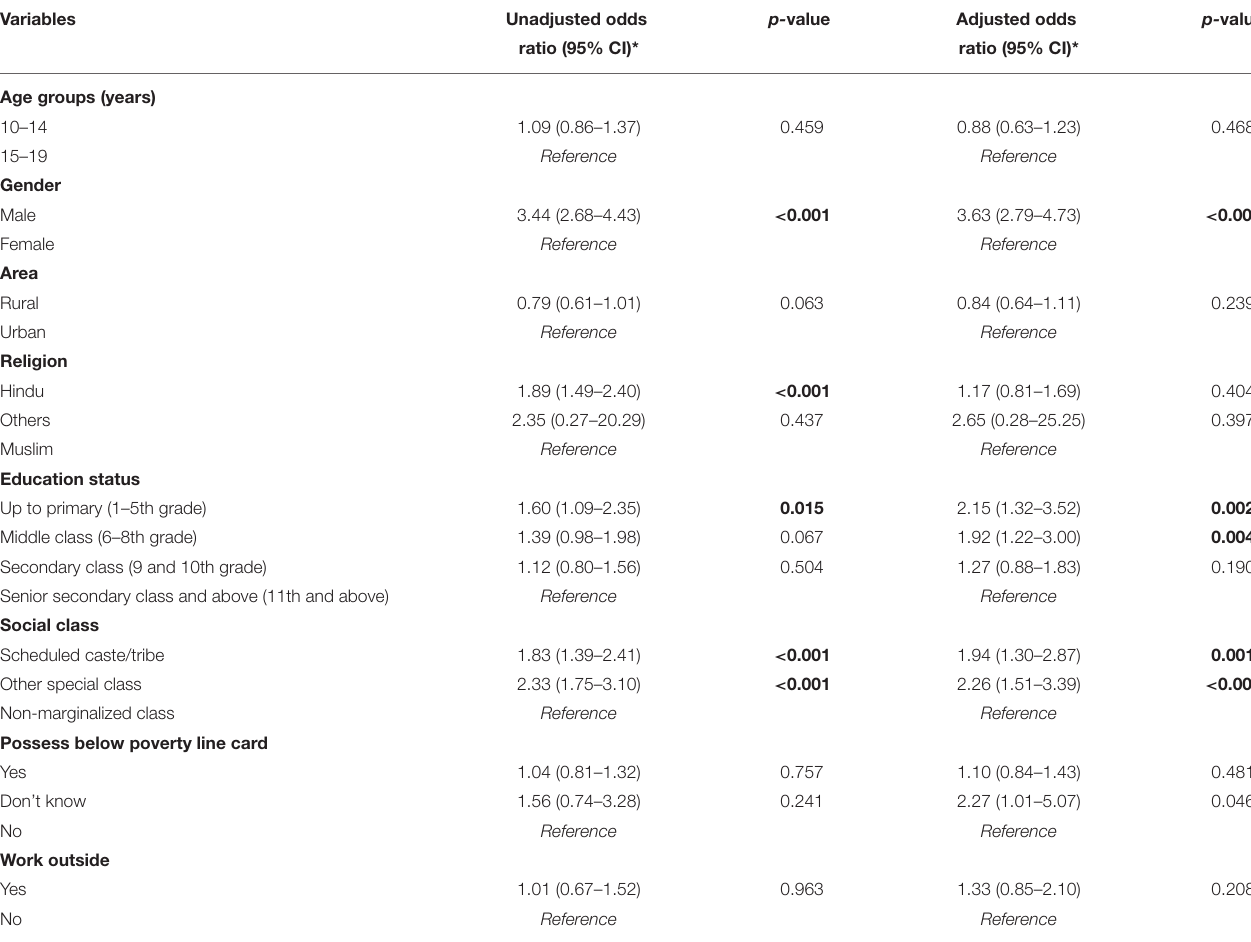
TABLE 4 | Logistic regression analysis showing results of unadjusted and adjusted odds ratio of the likelihood of the low-mixed diet with respect to selected background